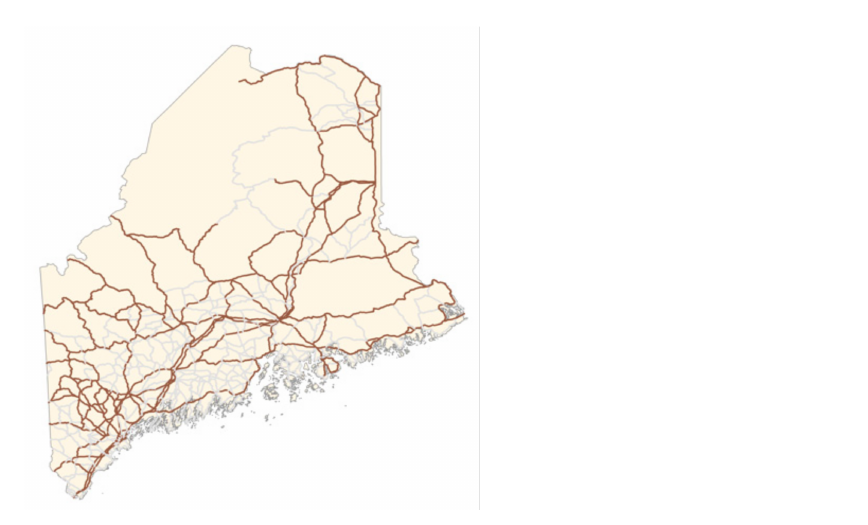
Figure 8. Standard road network map at 1:2,000,000 scale in the Maine area.